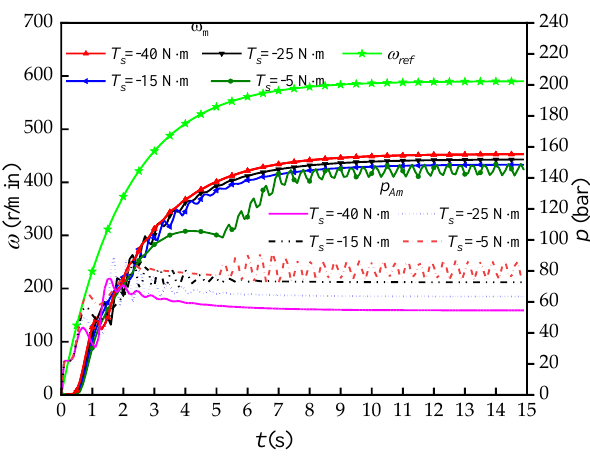
Figure 8. T-CBV system responses under different negative torque T s